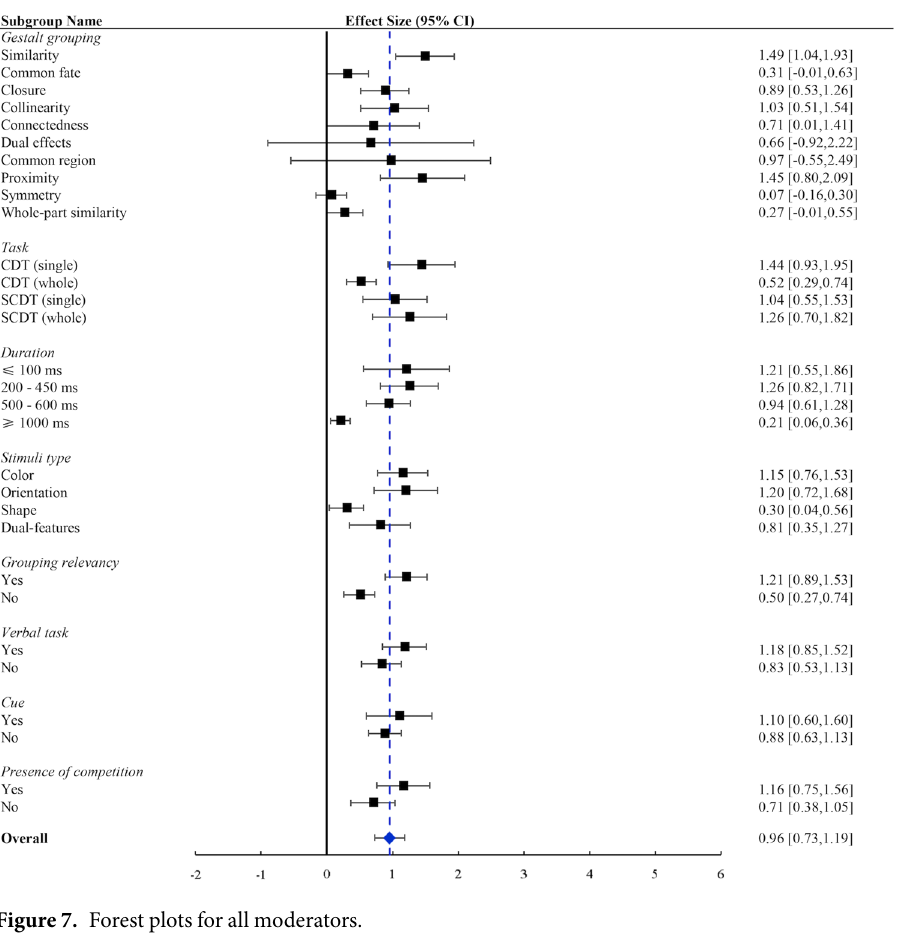
Figure 7. Forest plots for all moderators.